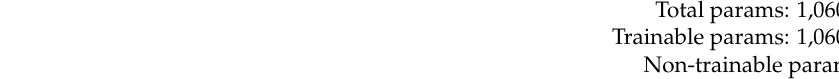
Figure 2. The Architecture of Convolutional Neural Network.